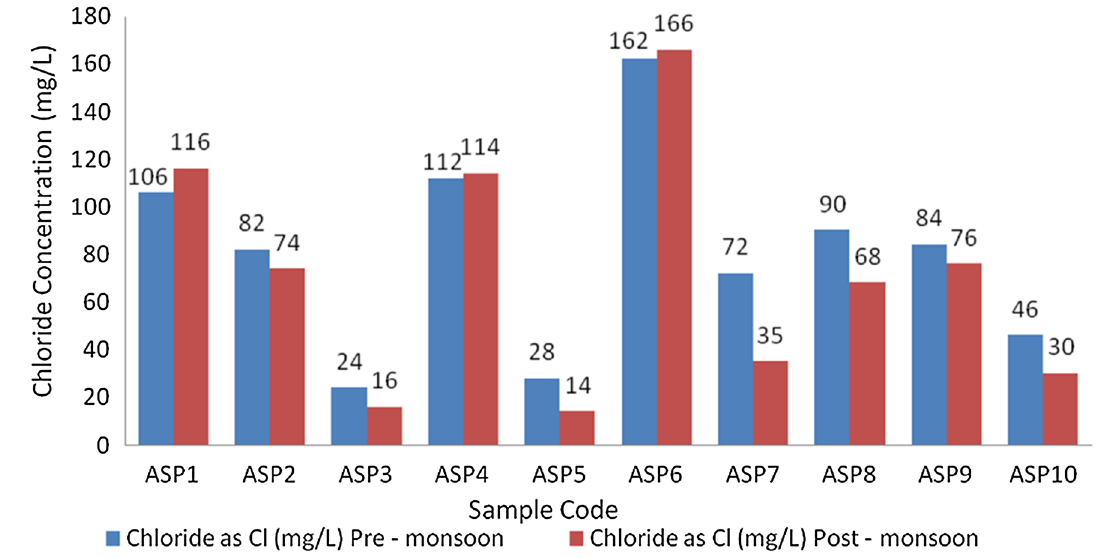
Fig. 14 Chloride concentration in samples BIS limit (1000 mg/L) collected from Laxmi Nagar